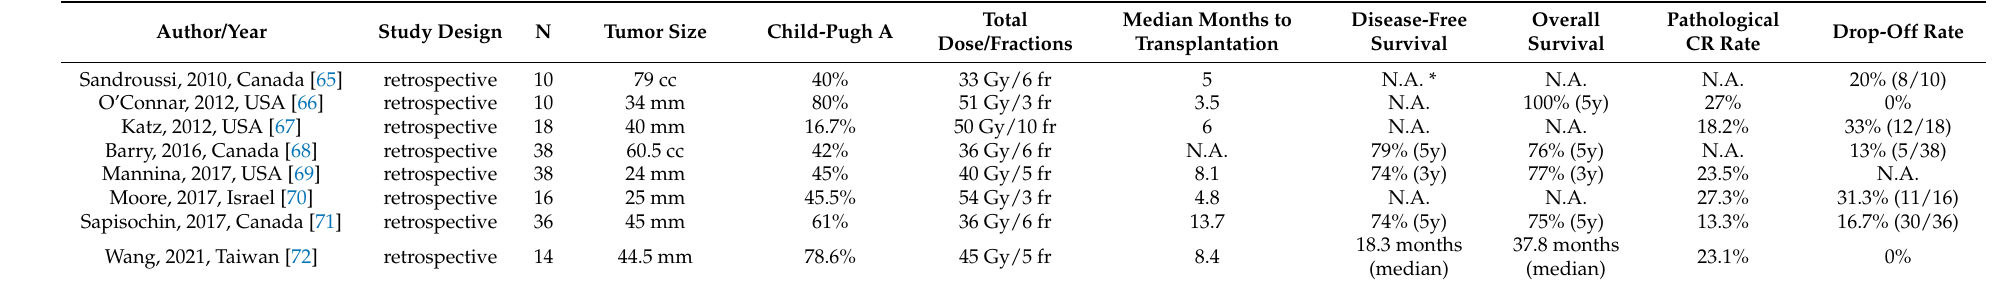
Table 4. Results of stereotactic body radiotherapy as a bridging